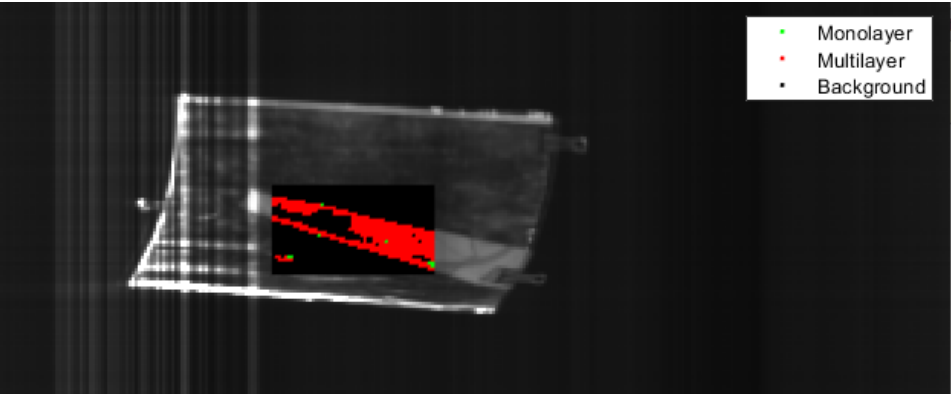
Figure 24. Classification of PE/PET multilayer film with the SNN.